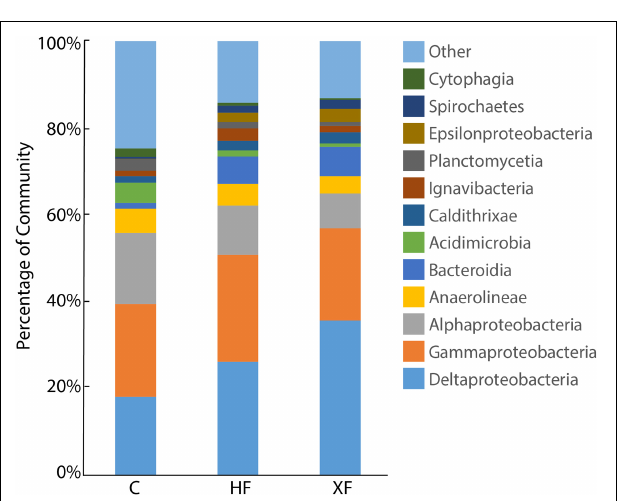
FIGURE 5 | Stacked bar plot of potentially active microbial classes in control (C), highly fertilized (HF), and extra highly fertilized (XF) setiments. Classes identified accounted for at least 1% of the 16S rRNA sequence dataset. Microbial classes that individually accounted for less than 1% of the dataset are combined into the “Other”